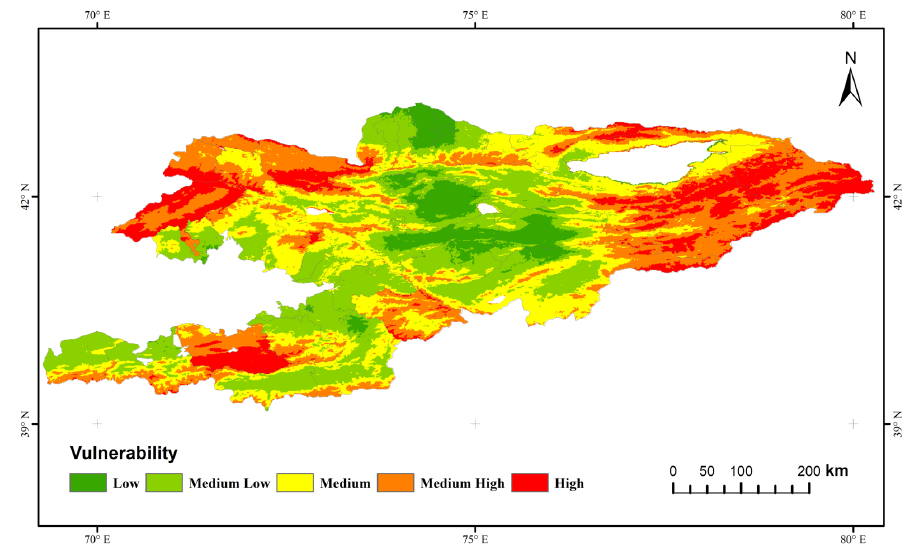
Figure 5. Agricultural system drought vulnerability index map of Kyrgyzstan.